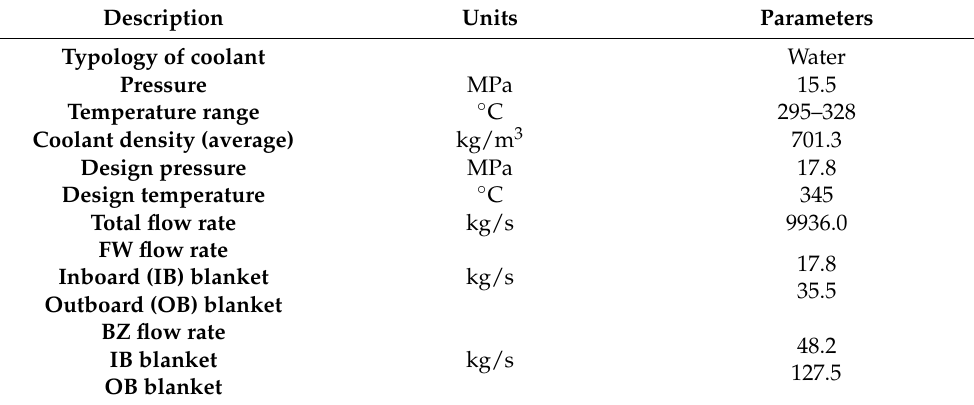
Table 1. WCLL DCD BOP BB cooling system parameters [3].